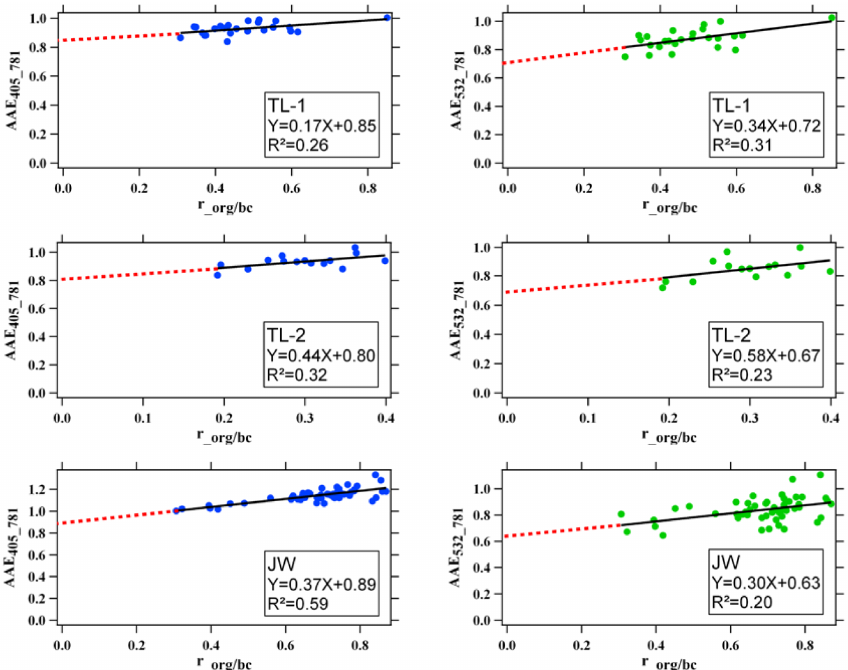
Figure 3. The linear relationship between AAE and r org/bc in the tunnel experiments.